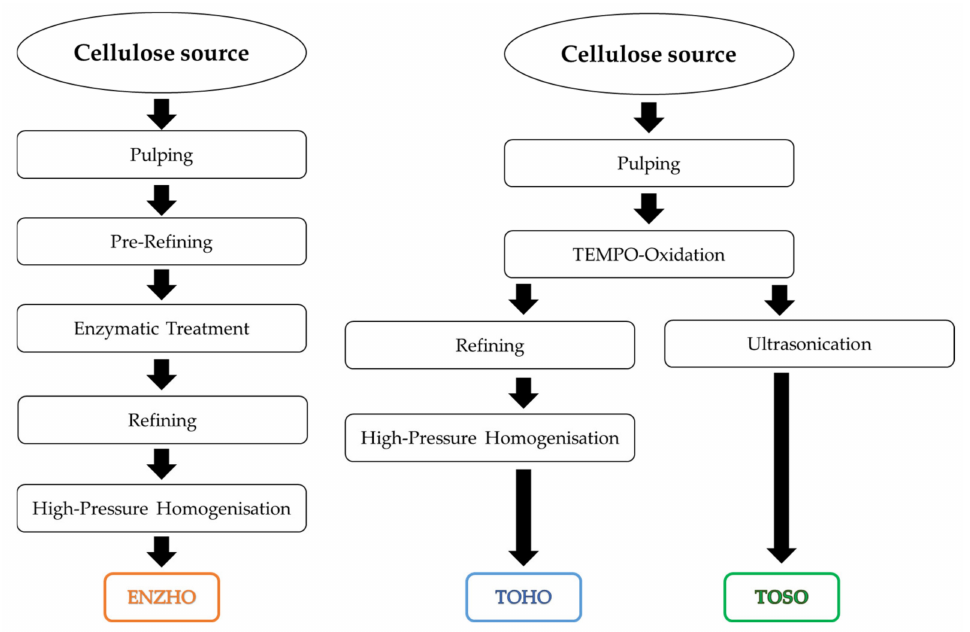
Scheme 2. Processes for the preparation of the three different types of cellulose